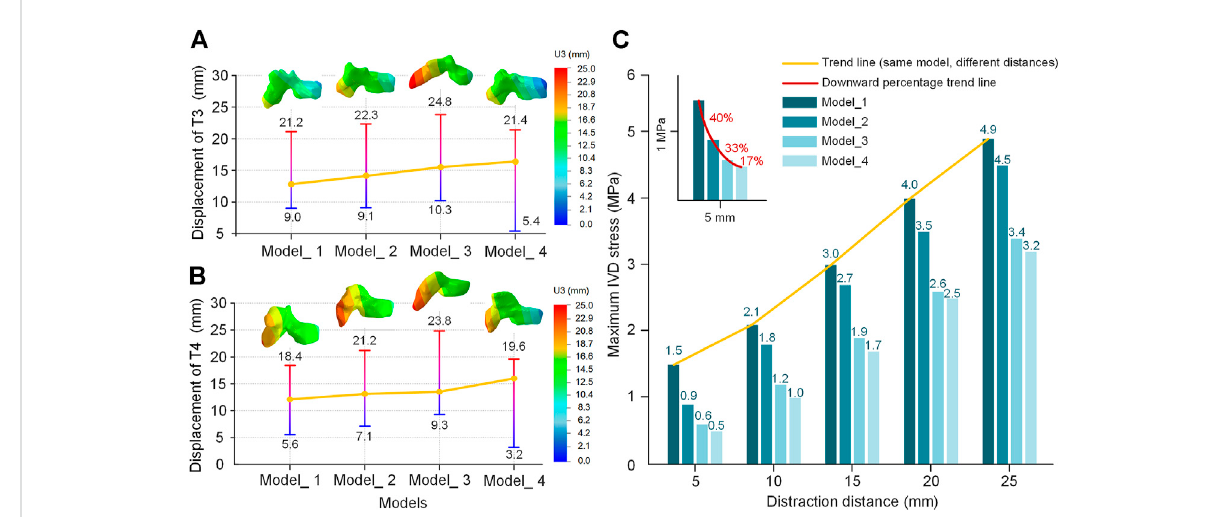
FIGURE 9 The displacement of the T3 and T4 vertebra in the U3 direction (distraction distance is 25 mm). (A) Displacement of T3. (B) Displacement of T4. (C) ThemaximumIVDstressoffourmodelsfromdifferentgrowthphasesatdifferentdistractiondistances.Theasymptotesrepresentchangesgoing from a low value (blue) to a high value (red). The yellow line is the difference between the low value and high